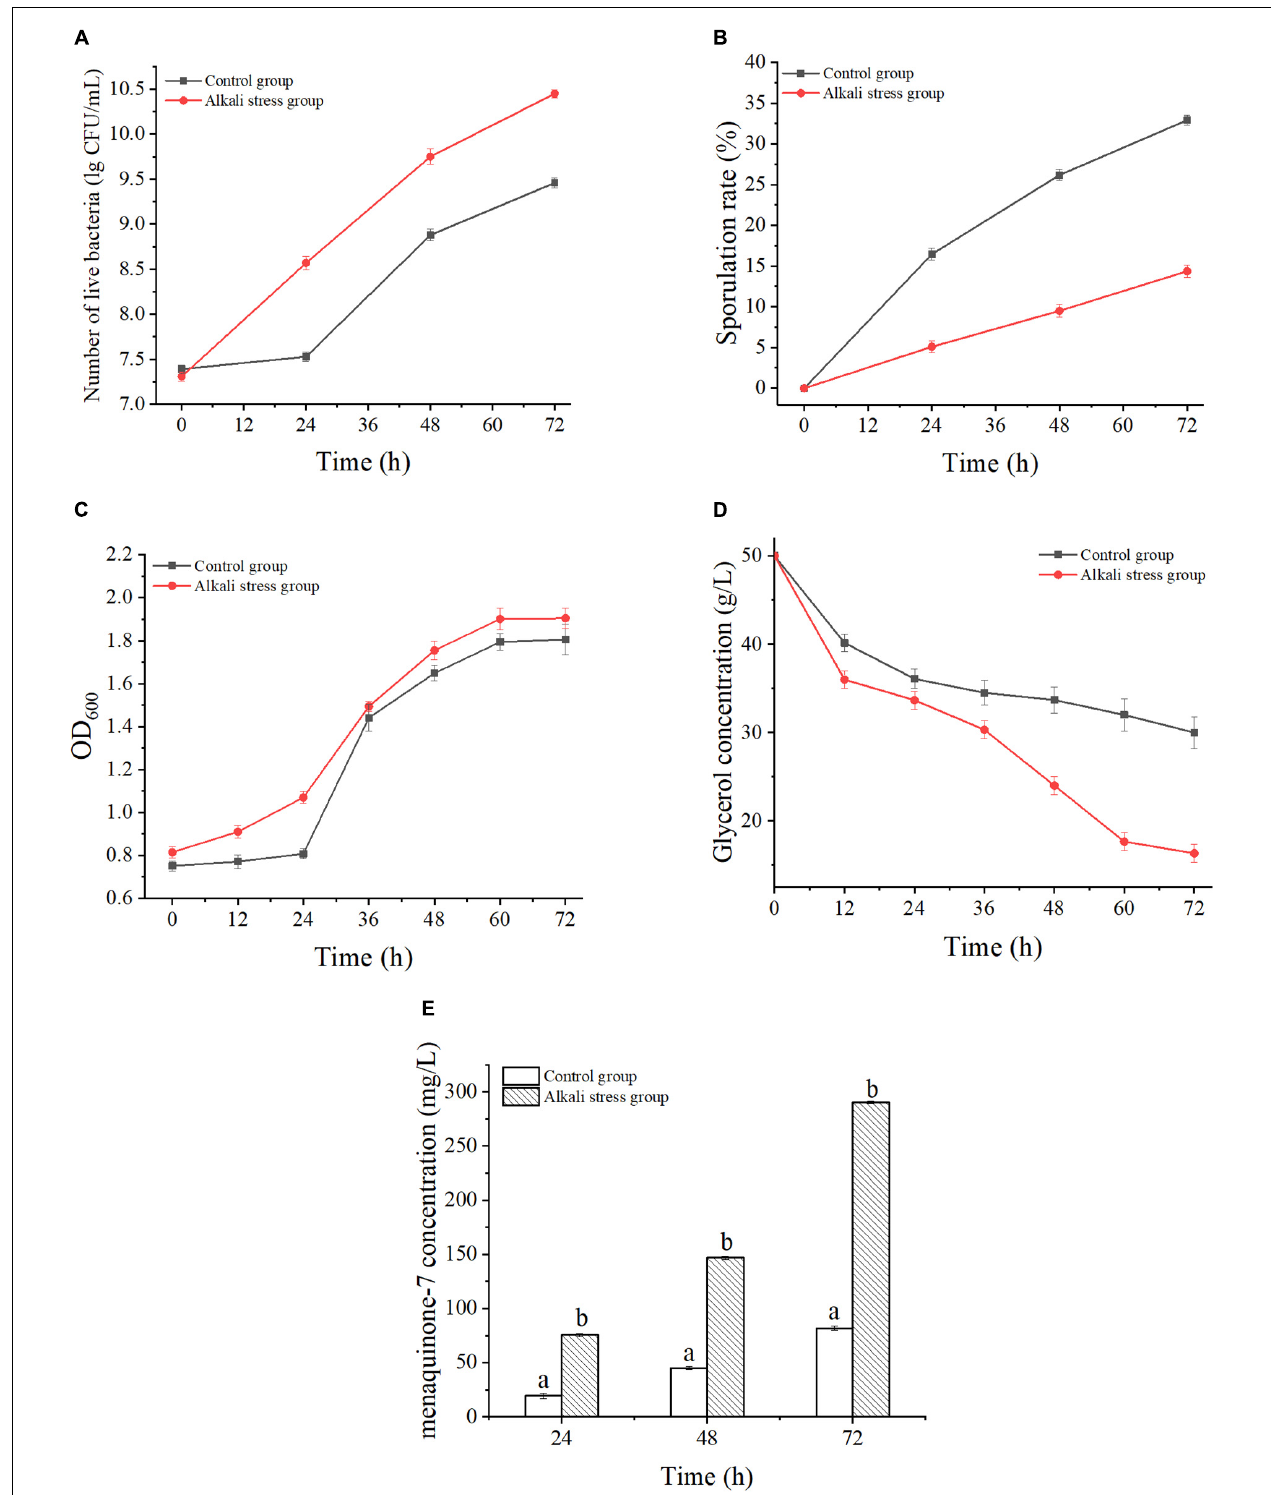
FIGURE 2 | Fermentation characteristics of Bacillus subtilis natto CICC10262 under alkali stress. (A) Live bacteria, (B) Sporulation rate, (C) Cellular biomass (OD 600 ), (D) Glycerol consumption, (E) MK-7 yield. Differences in lowercase letters indicate significant differences between the two groups of values at the same time, P < 0.05.